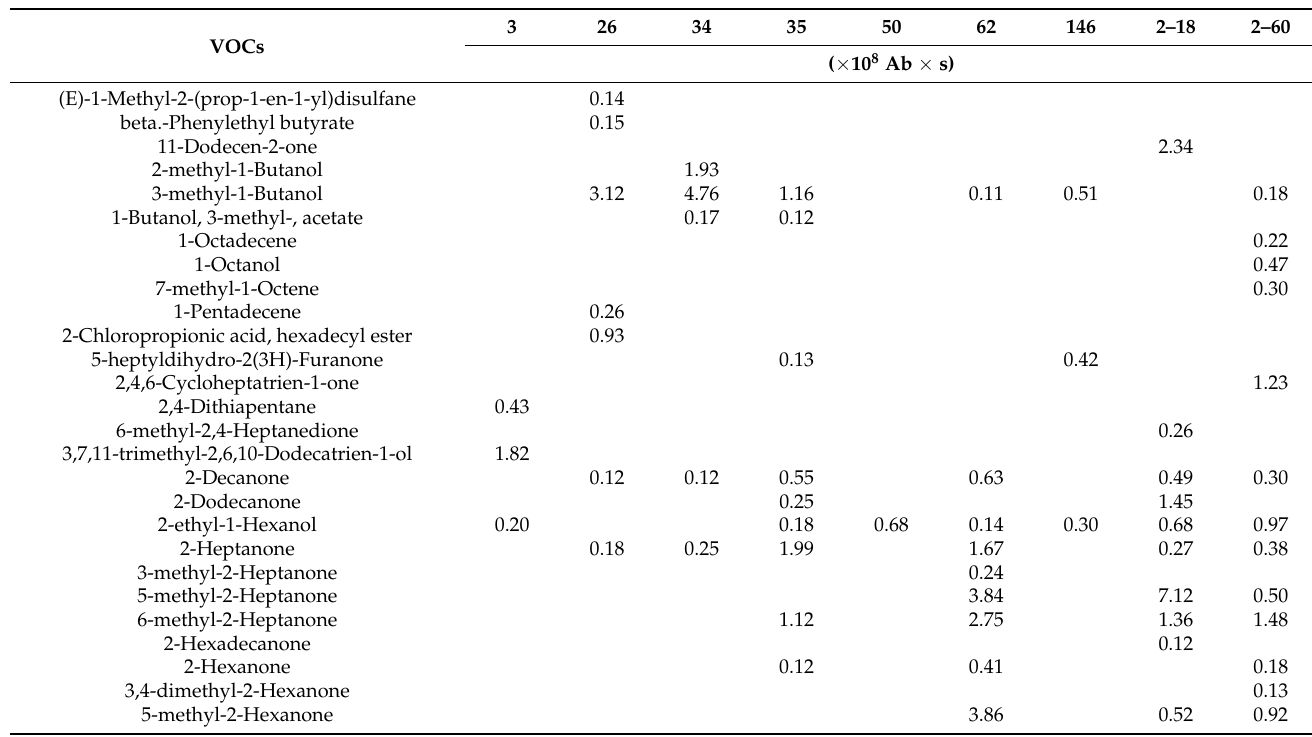
Table 1. Composition of VOCs produced by different bacterium and their peak area on mass spectrum.